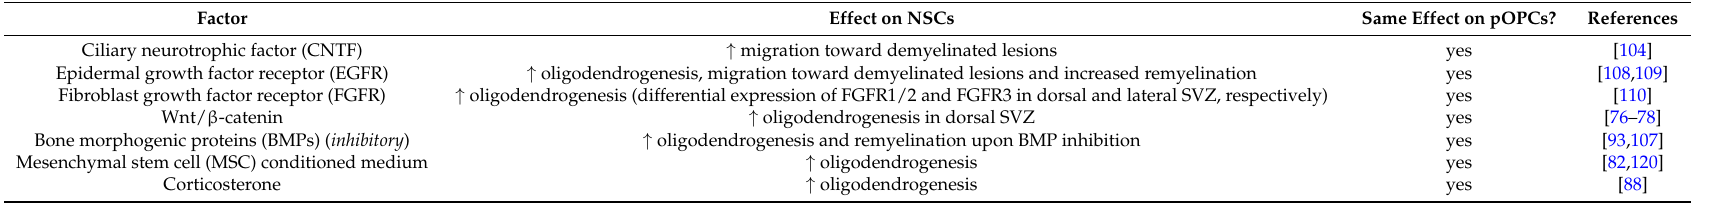
Table 2. Summary of extrinsic factors and their oligodendrogenic effects on NSCs and